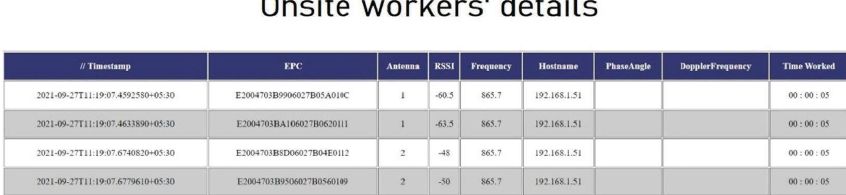
Figure 22: On-site details displayed on developed web